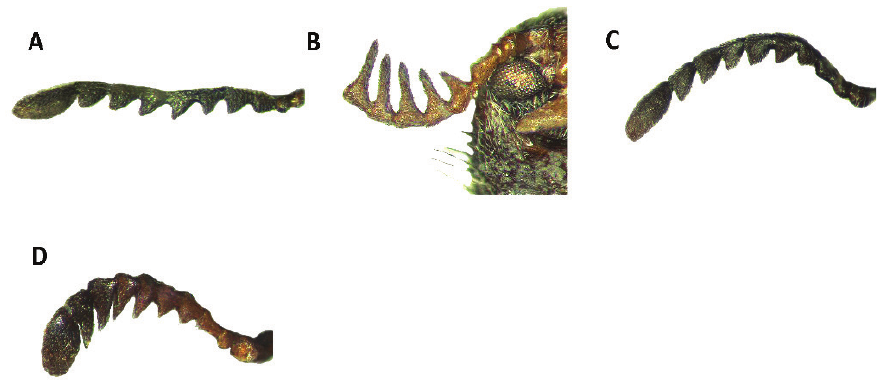
Figure 11. Antennae of: A Callotillus bahamensis (male) B Neocallotillus intricatus (male) C Callotillus bahamensis (female) D Neocallotillus intricatus